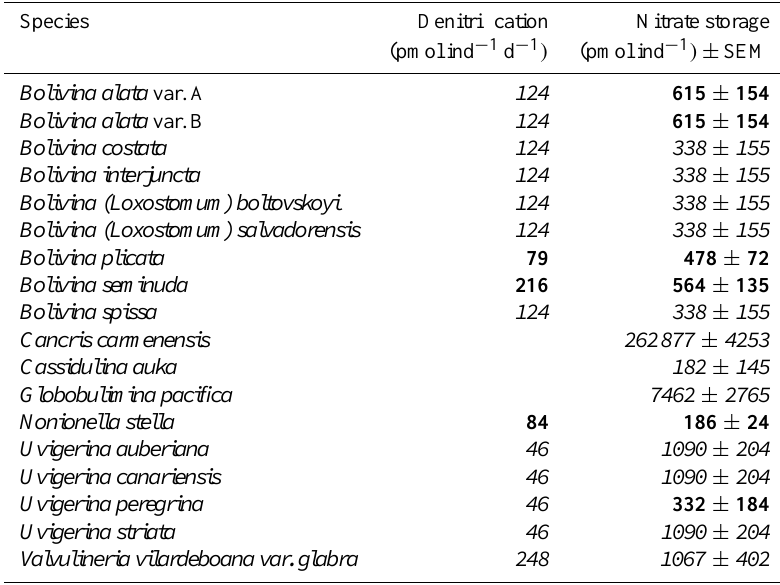
Table 2. Individual foraminiferal denitrification rates and nitrate storage for the different species used to calculate total benthic foraminiferal denitrification and nitrate storage at the different sampling sites. Bold numbers represent species where literature data was available for the distinct species. Numbers in italics were calculated using assumption A (mean values of other species from the same genus). Data are from Pi˜na-Ochoa et al. (2010a) except for the denitrification rate of Nonionella stella (Risgaard-Petersen et al.,